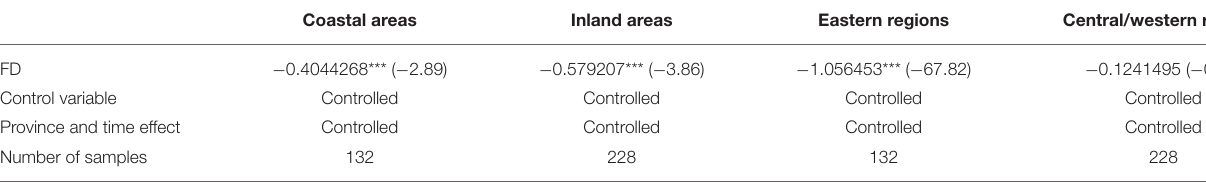
TABLE 7 | Regional regression results.